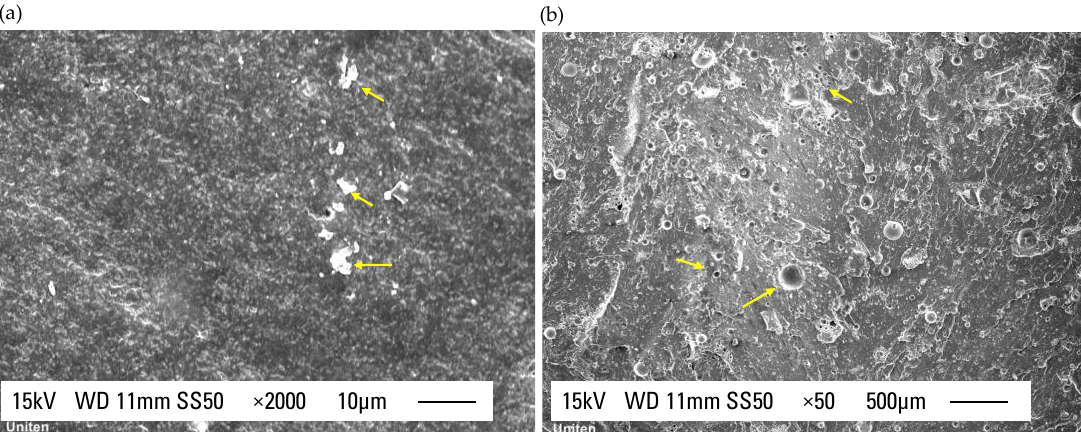
Figure 3. SEM analysis for (non-shredded samples) ( a ) RPF1, ( b ) RPF4. The yellow arrows show the particle cracks and agglomerates.